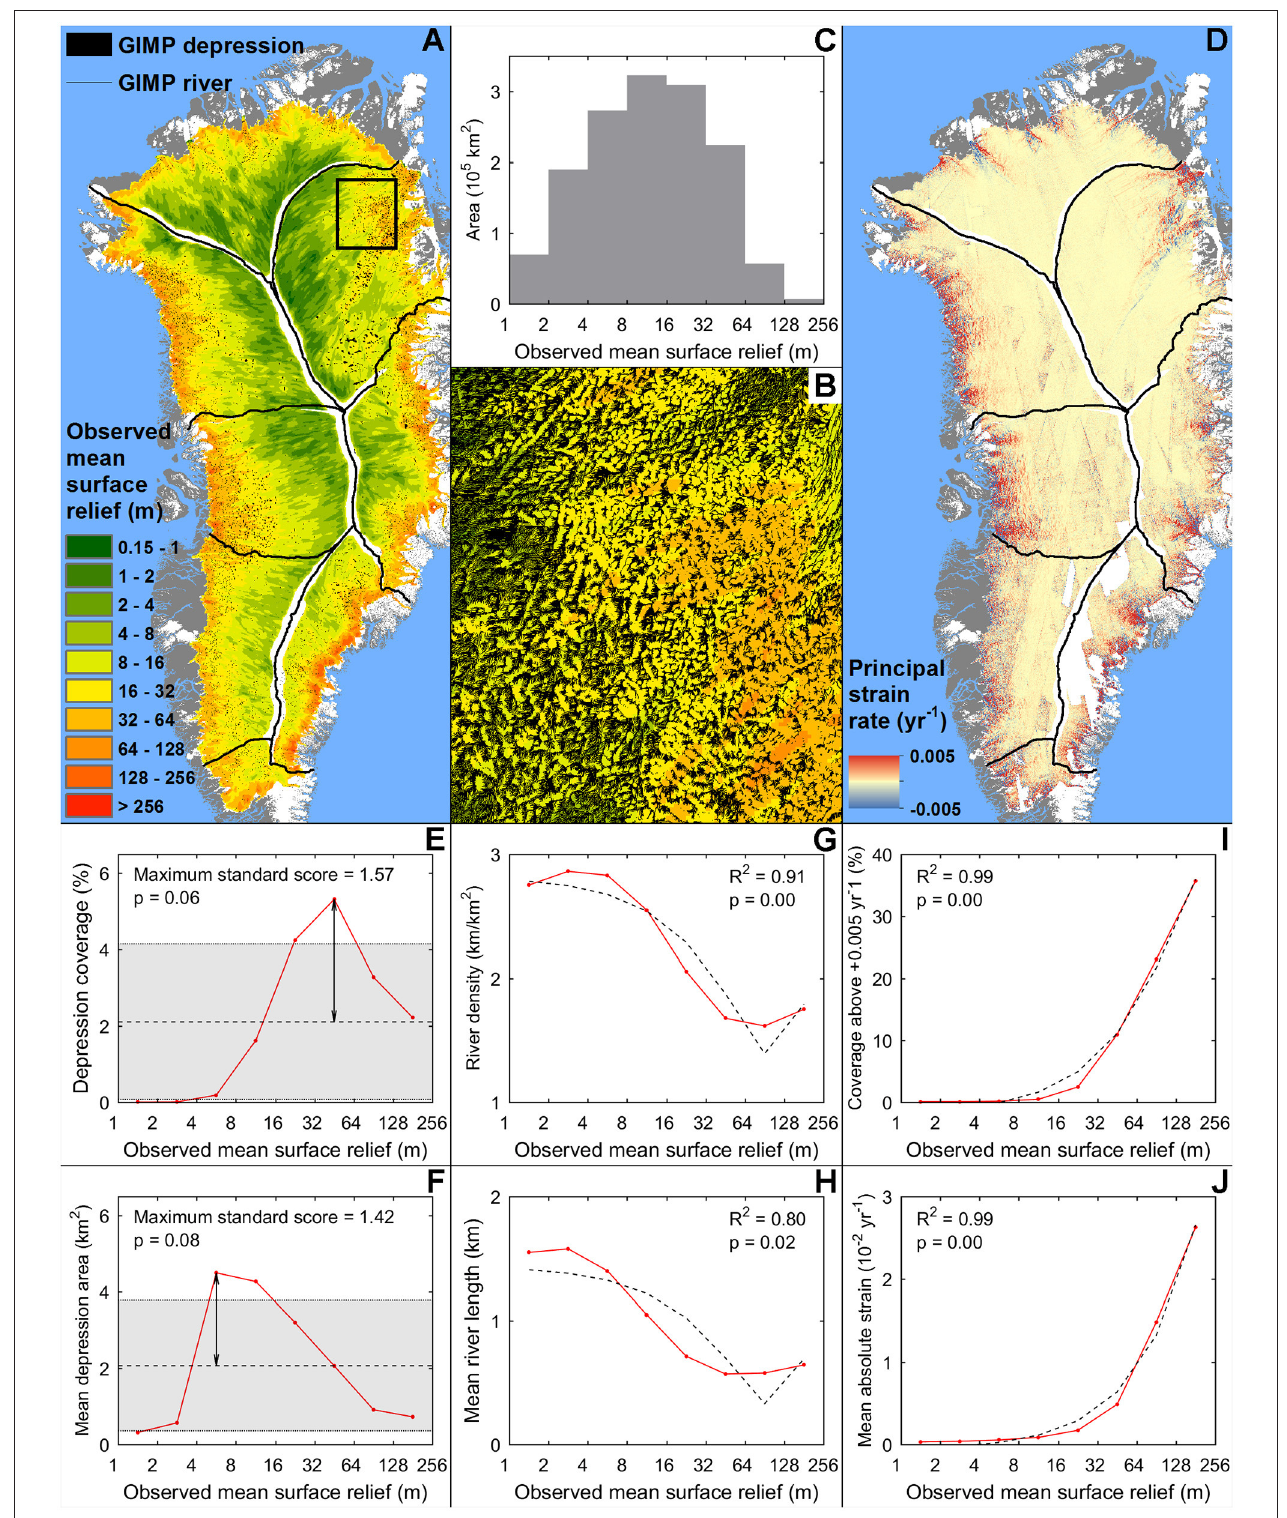
FIGURE 10 | (A) Observed mean surface relief map compared with the distribution of GIMP-DEM derived closed surface depressions of the whole ice sheet (B) and GIMP-DEM derived rivers of NE Greenland. (C) Area covered by the observed mean surface relief categories of the GrIS is also shown; categories smaller than 4,500 km 2 have been removed. (D) The ice sheet wide principal strain rate is also shown. (E) The coverage (F) and mean area of the GIMP-DEM derived depressions